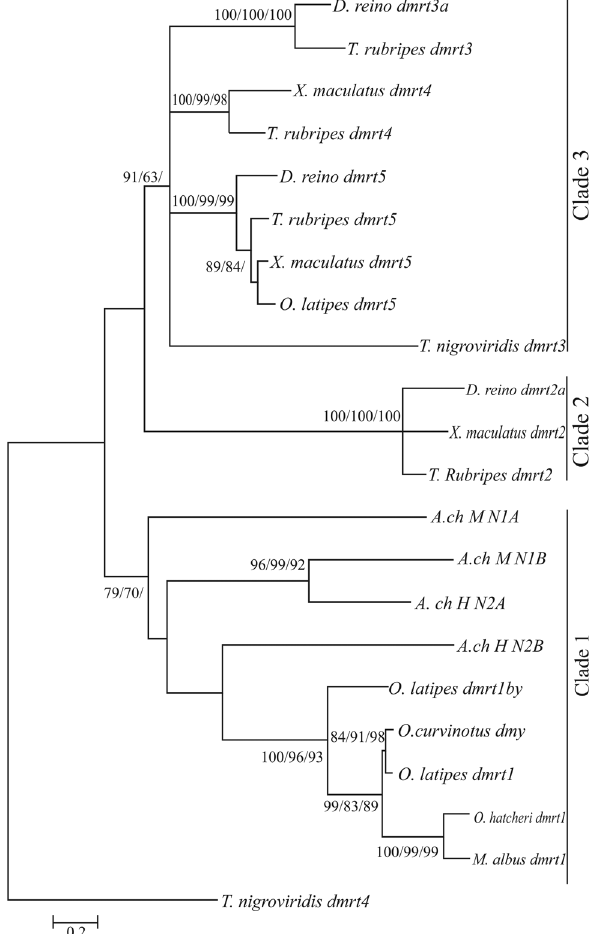
Figure 2 - Maximum Likelihood analyses [under general time-reversible model with gamma correction (GTR+G)], based on partial genome se- quences isolated from Austrolebias charrua and Dmrt gene family se- quences retrieved from GenBank (Table 2). Numbers above the branches (left to right) correspond to the Bayesian posterior probability for clades obtained using BEAST 1.5.4v, followed by ML and MP boostrap support (> 60%) respectively, recovered in 1000 replicates. M N1A, M N1B, H N2A and H N2B: Austrolebias charrua genomic